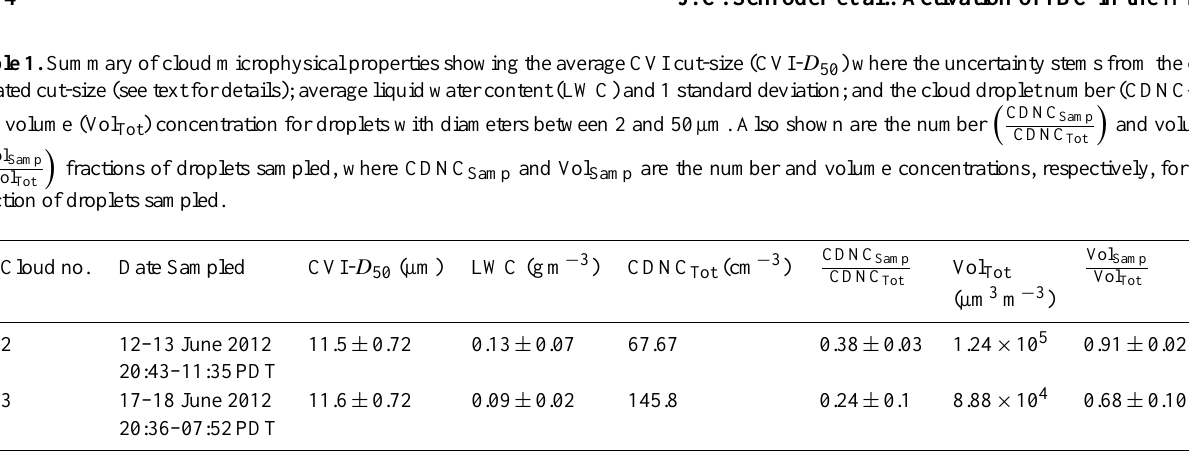
(cid:16) CDNC (cid:17) Samp and volume CDNC Tot